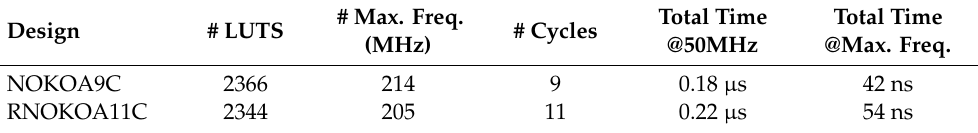
Table 1. Synthesis results for NOKOA9C and RNOKOA11C over GF(2 233 ) on Virtex 5 devices.